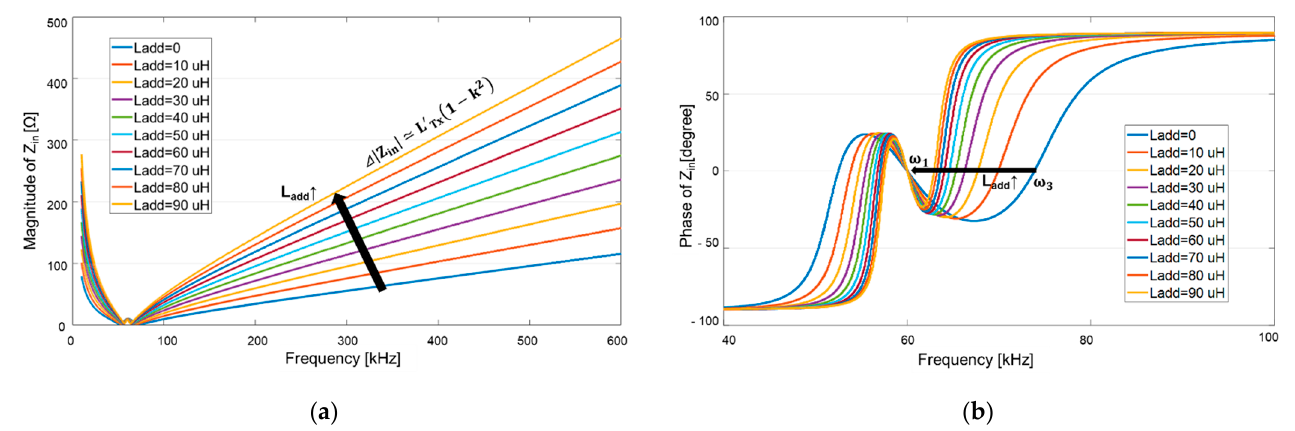
Figure 14. Input impedance change according to the series inductance value (L add-tx , L add-rx ): ( a ) input impedance magnitude change according to frequency change; ( b ) input impedance phase change according to frequency change.